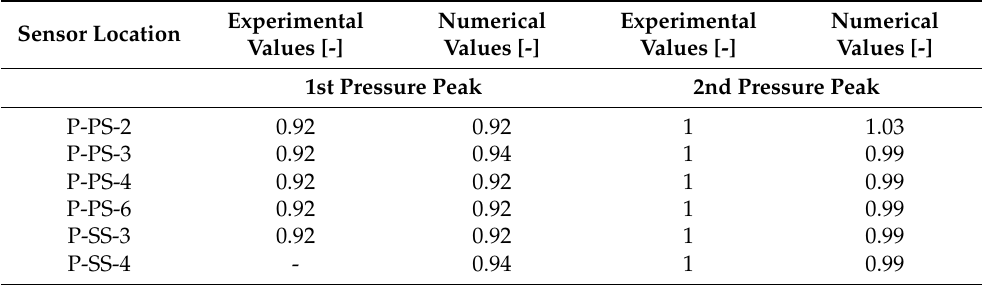
Table 5. Numerical and experimental normalized frequency values corresponding to the pressure peaks captured on the runner blades.